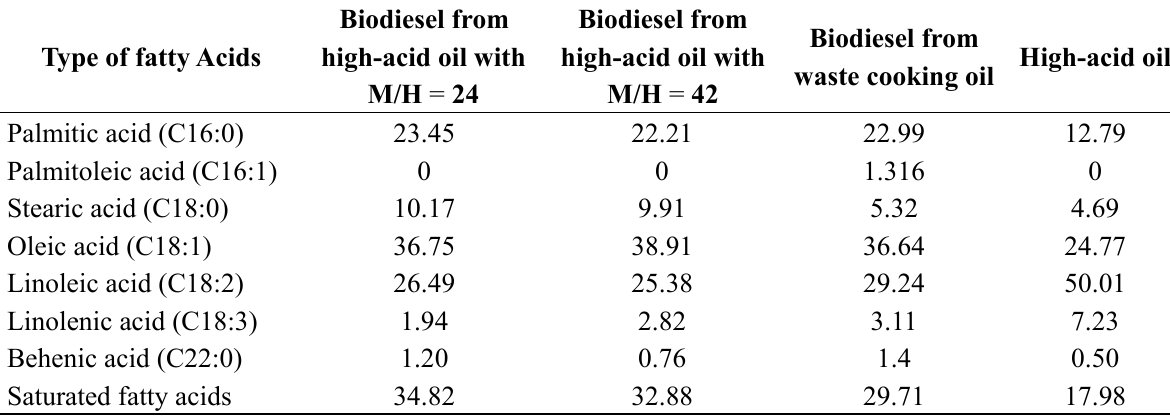
Table 2. Comparison of the fatty acid composition (wt %) of the high acid-oil biodiesel produced with molar ratios of methanol/raw oil of 24 and 42 with that of waste cooking oil biodiesel and the raw high-acid oil. Biodiesel from Biodiesel from Biodiesel from Type of fatty Acids high-acid oil with high-acid oil with M/H = 24 M/H = 42